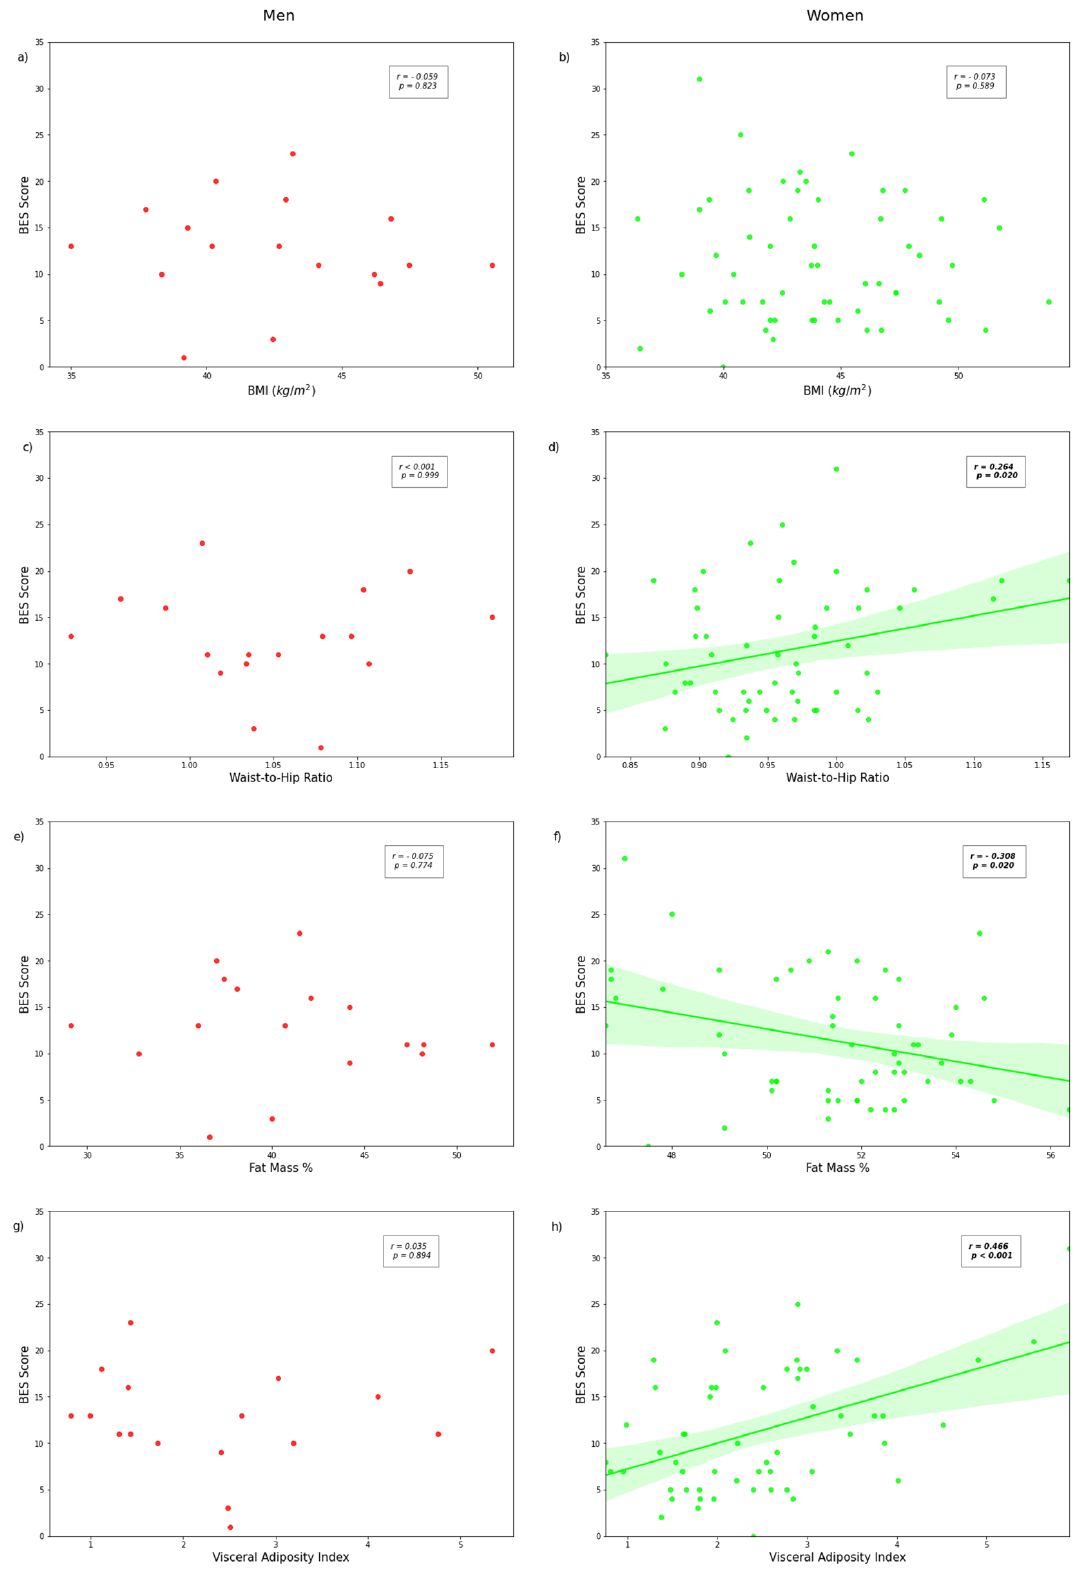
Figure 2. Correlations between binge eating scores and BMI (( a ) for men and ( b ) for women), waist-to-hip ratio (( c ) for men and ( d ) for women), fat mass % (( e ) for men and ( f ) for women), or visceral adiposity index (VAI) (( g ) for men and ( h ) for women). Figures show scatterplot with regression line and its 95% confidence interval in which relevant (using seaborn regplot). Pearson correlation coefficients and p values are shown. Significant associations are highlighted in